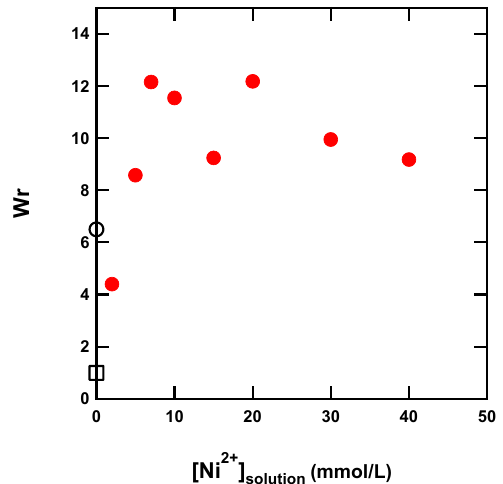
Figure 4. Swelling ratio of dual-crosslink hydrogels in Ni 2+ solutions of different concentrations (filled circles). The value of the chemical gel as prepared is 1, plotted as an open square, and that of the chemical gel at equilibrium swelling in water (corresponding to a weight percentage in water of around 97.5%) is indicated by the open circle at about 6.5.